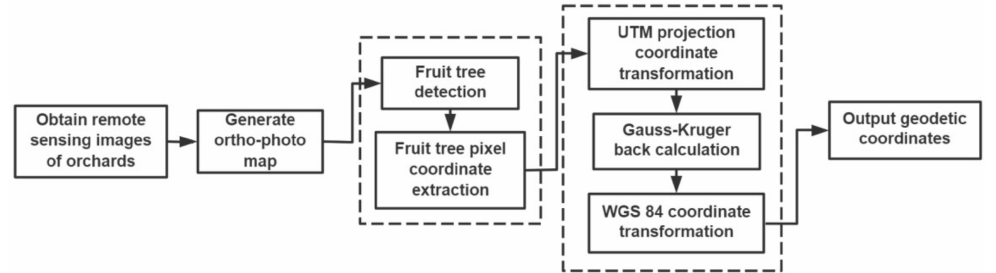
Figure 2. Overall flow chart: image acquisition, orthophoto map production, citrus tree identification, coordinate